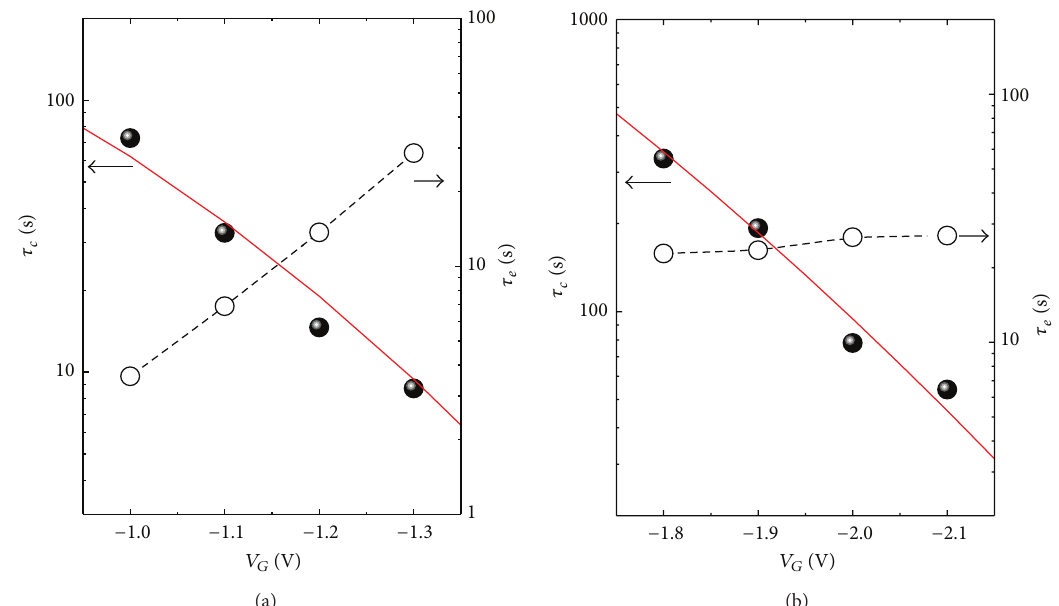
Figure 4: Field dependence of the average value of 𝜏 𝑐 and 𝜏 𝑒 of the RTN under (a) higher and (b) lower gate bias regions. The red lines present MPFAT simulation results for 𝜏 𝑐 .